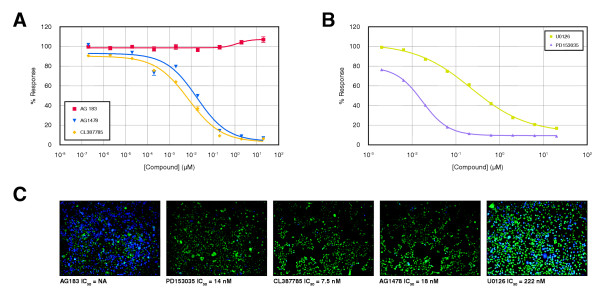
Potency of individual inhibitors towards kinases in the AP-1 pathway determined in a dose response manner. Inhibitors were used in a dose response manner on the AP-1-bla ME180 CellSensor, and β-lactamase measured using Invitrogen's liveBLAzer™ FRET B/G assay (Panels A and B). IC50 determinations were performed using GraphPad Prism® and values shown with images of inhibitors at 0.2 μM concentration (Panel B).